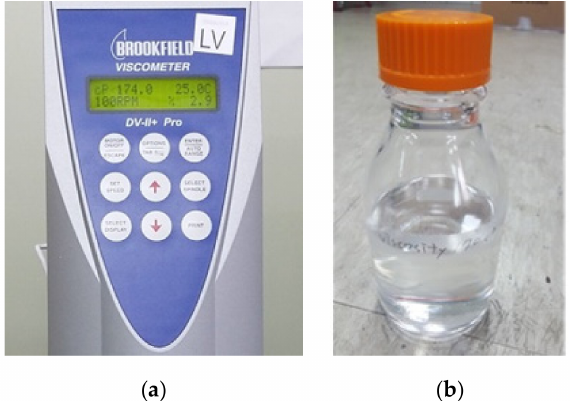
Figure 8. ( a ) Viscosity measurement for the vaccine, and ( b ) 170 cP liquid silicon with the same fluidic properties as the